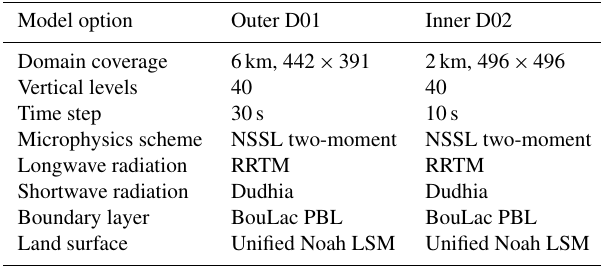
Table 1. Settings for the nested